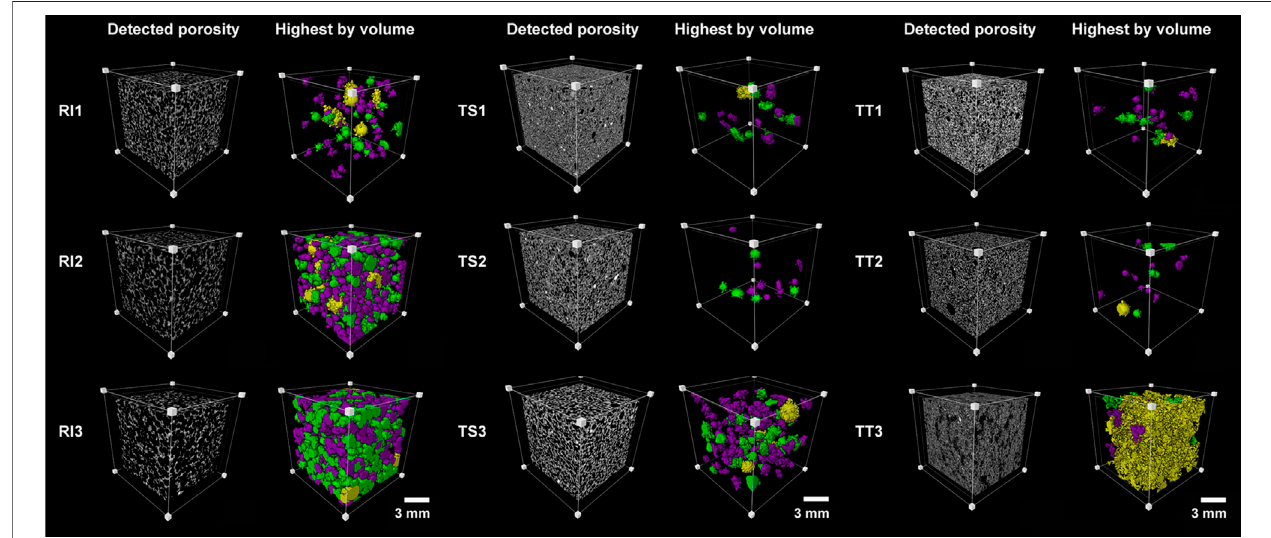
FIGURE 6 | Region of interest of the analyzed alkali-activated foams cured at 70 ° C (RI, TS, and TT fl y ash, 1, 2, and 3 represent the amount of foaming and stabilizingagentsused)presentinggrayscaleimagesandthebiggestmainpores.ColorsdenotearangeofsizeclasseswithrespecttoEqDiameter:purple(0.85 – 1 mm), green (1 – 1.6 mm), and yellow (more than 1.6 mm).